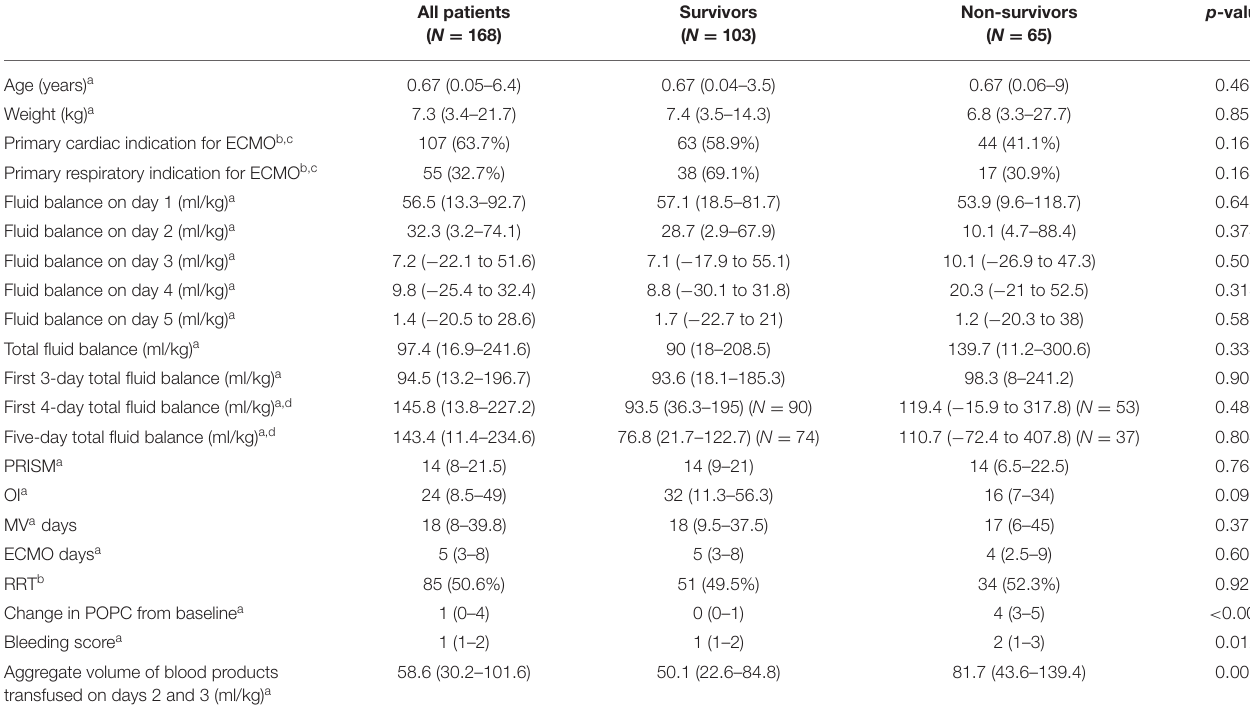
TABLE 1 | Comparison of risk factors and outcomes between survivors vs. non-survivors.